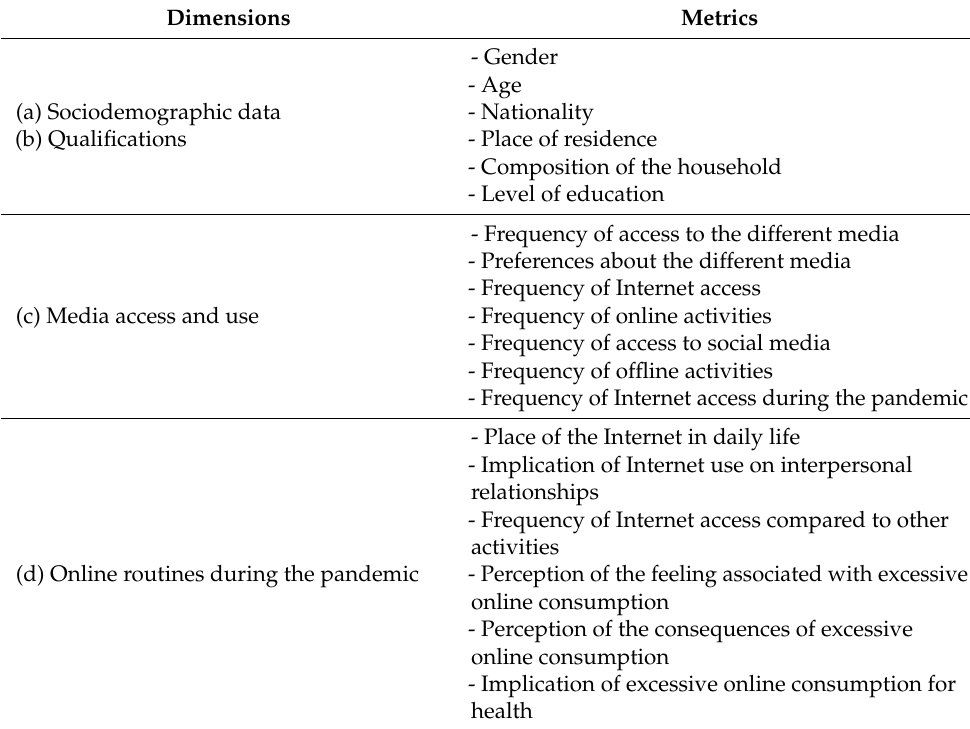
Table 2. Metrics according to